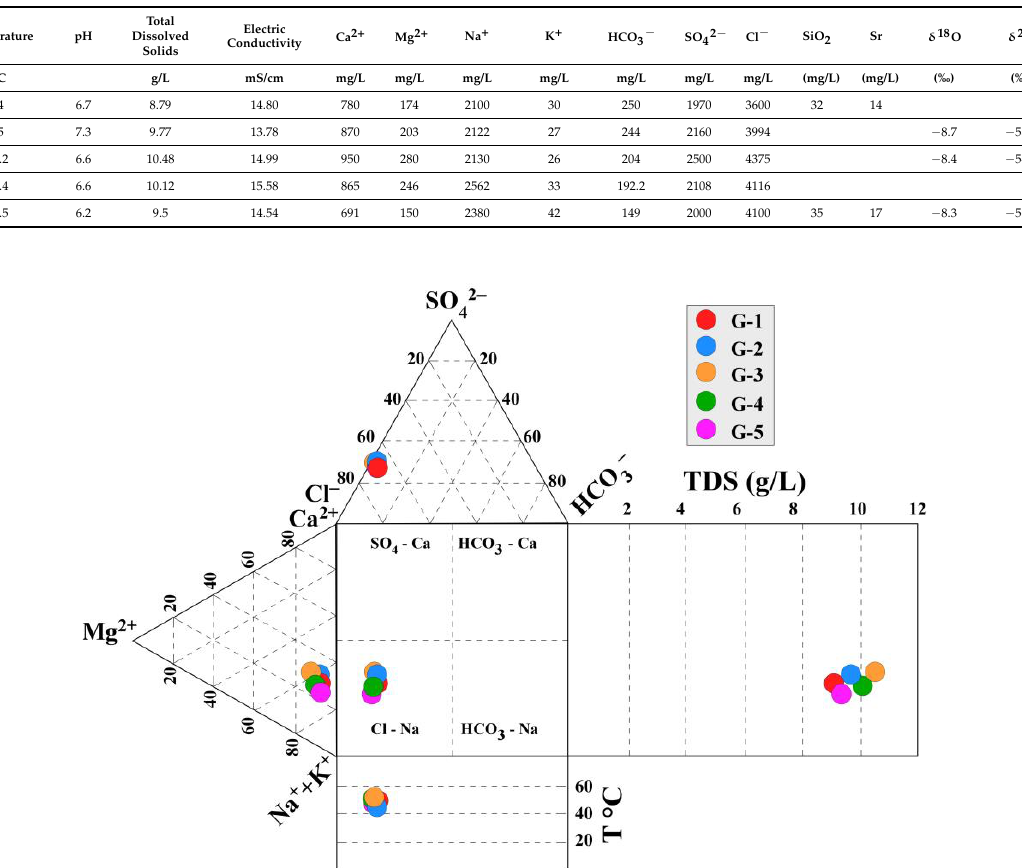
Table 1. Physico-chemical results of the thermal waters of Goutitir along 19 years.